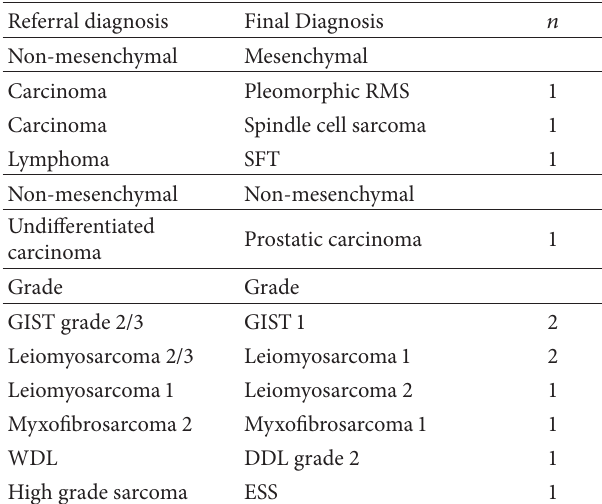
Table 3: Summary of cases showing major